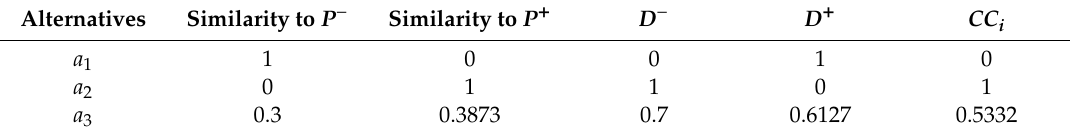
Table A2. Similarity and distances of PHFLTS to the positive and negative ideal